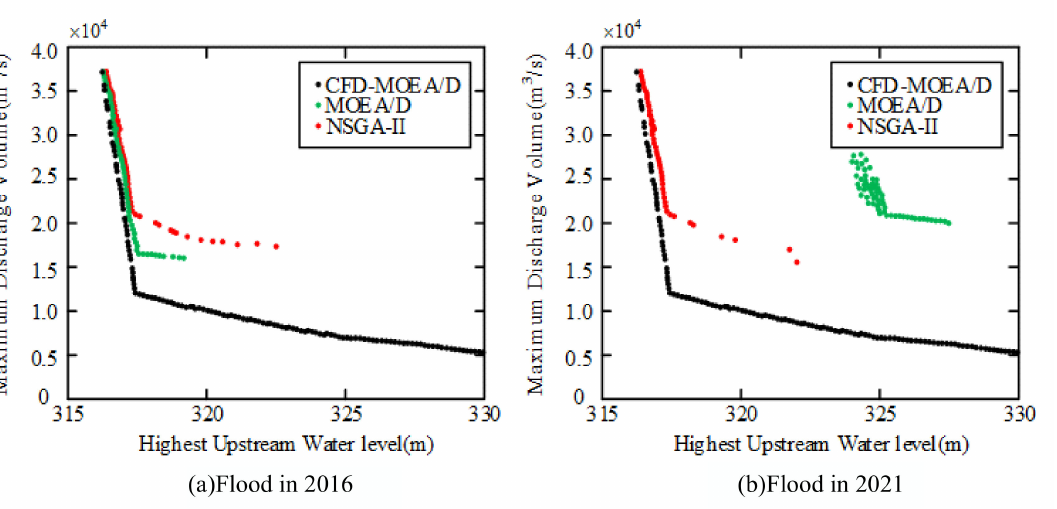
Figure 5. Comparison of three algorithms to obtain the best non dominant solution in 2016 flood and 2021 flood